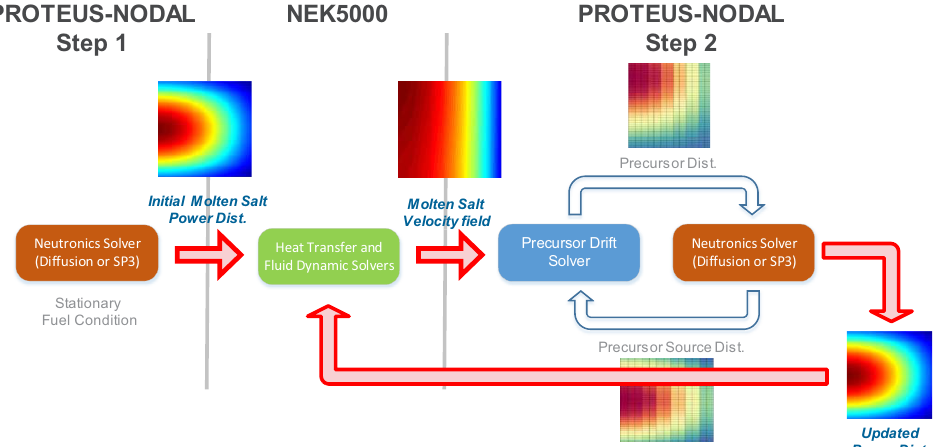
Figure 1. PROTEUS-NODAL/Nek5000 coupled solution approach for DNPs in fast MSRs .